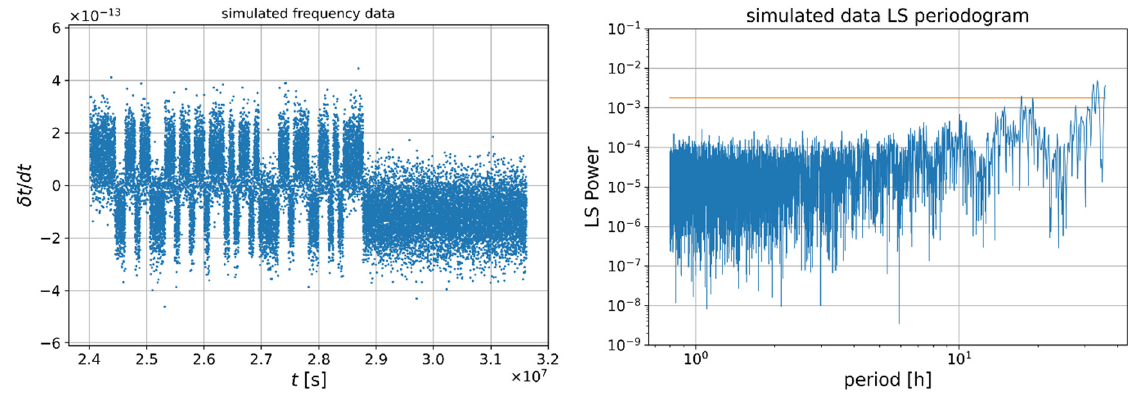
Figure 5. Simulated data with jumps ( left ) and its Lomb-Scargle periodogram ( right ). An example spectrogram for satellite C32 is shown in Figure 6. Visible is a component with a period of about 6.4 h, which appears from about 7200 h and continues until the end of the period analyzed.